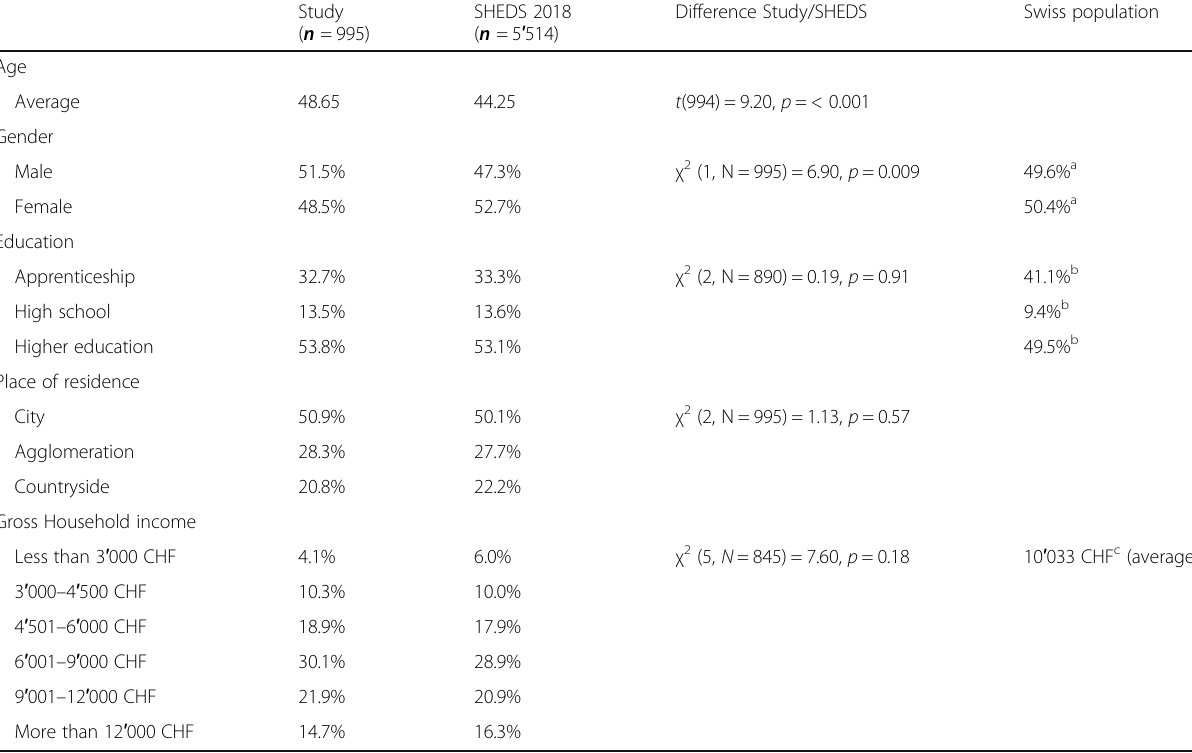
Table 2 Representativeness of study